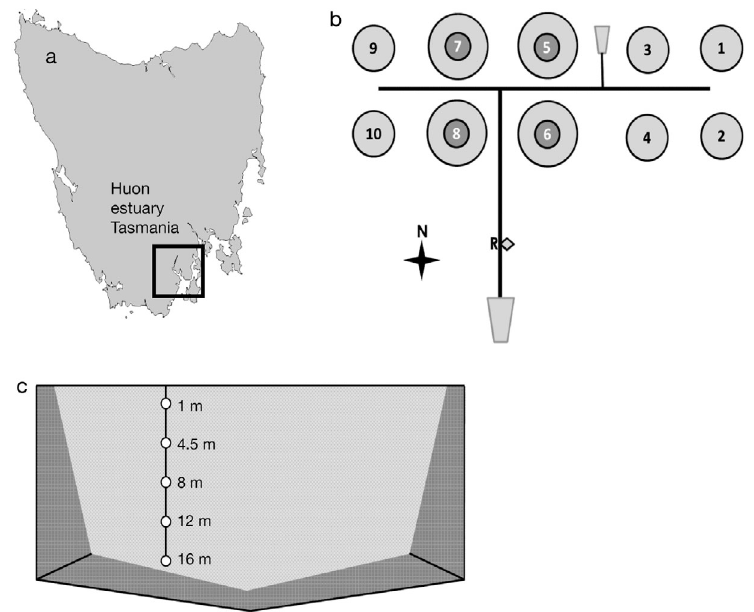
Fig. 1. (a) Geographic location of the farm site in south-eastern Tasmania, Australia. (b) Cage layout and orientation at the study site. Standard 168 m circumference cages (1,2,3,4,9,10) are represented by solid cir- cles, whereas large 240 m circumference cages (5,6,7,8) are circles with dark centres. The reference site 200 m south of the cages (diamond, R) and barges (grey polygons) are marked. (c) Diagram of the double- netted cage and location of dissolved O 2 loggers which were positioned midway between the edge and centre on the western side of each